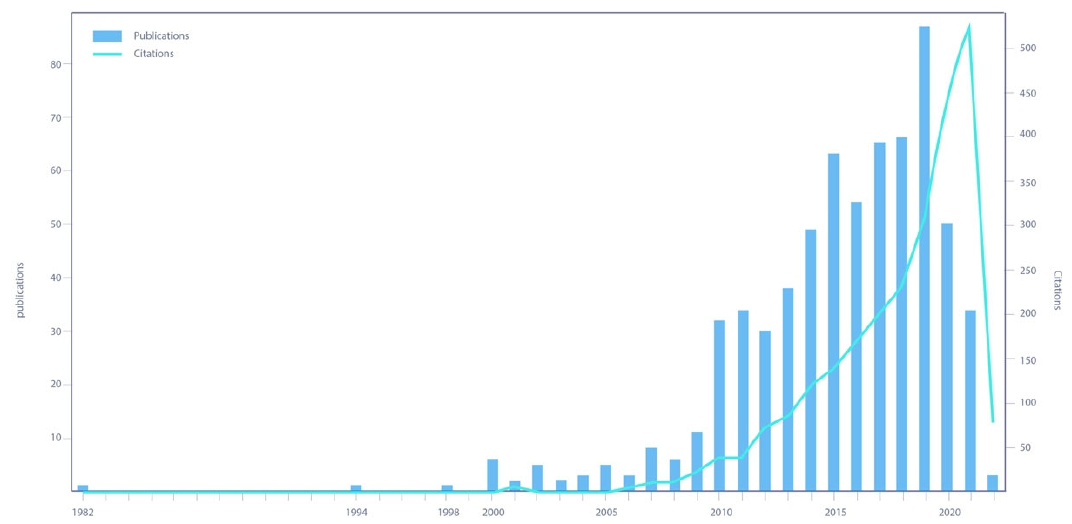
Figure 2. Times cited and publications over time.